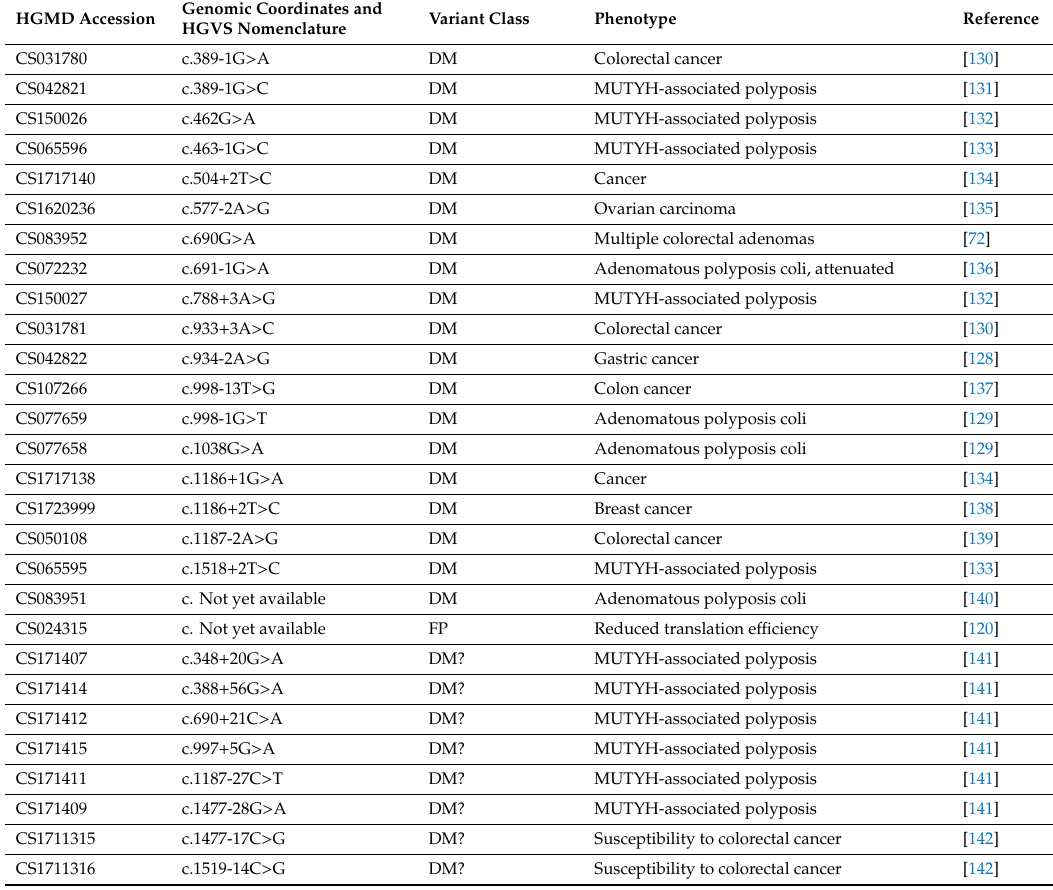
Table 3. Pathogenic splice variants of MUTYH